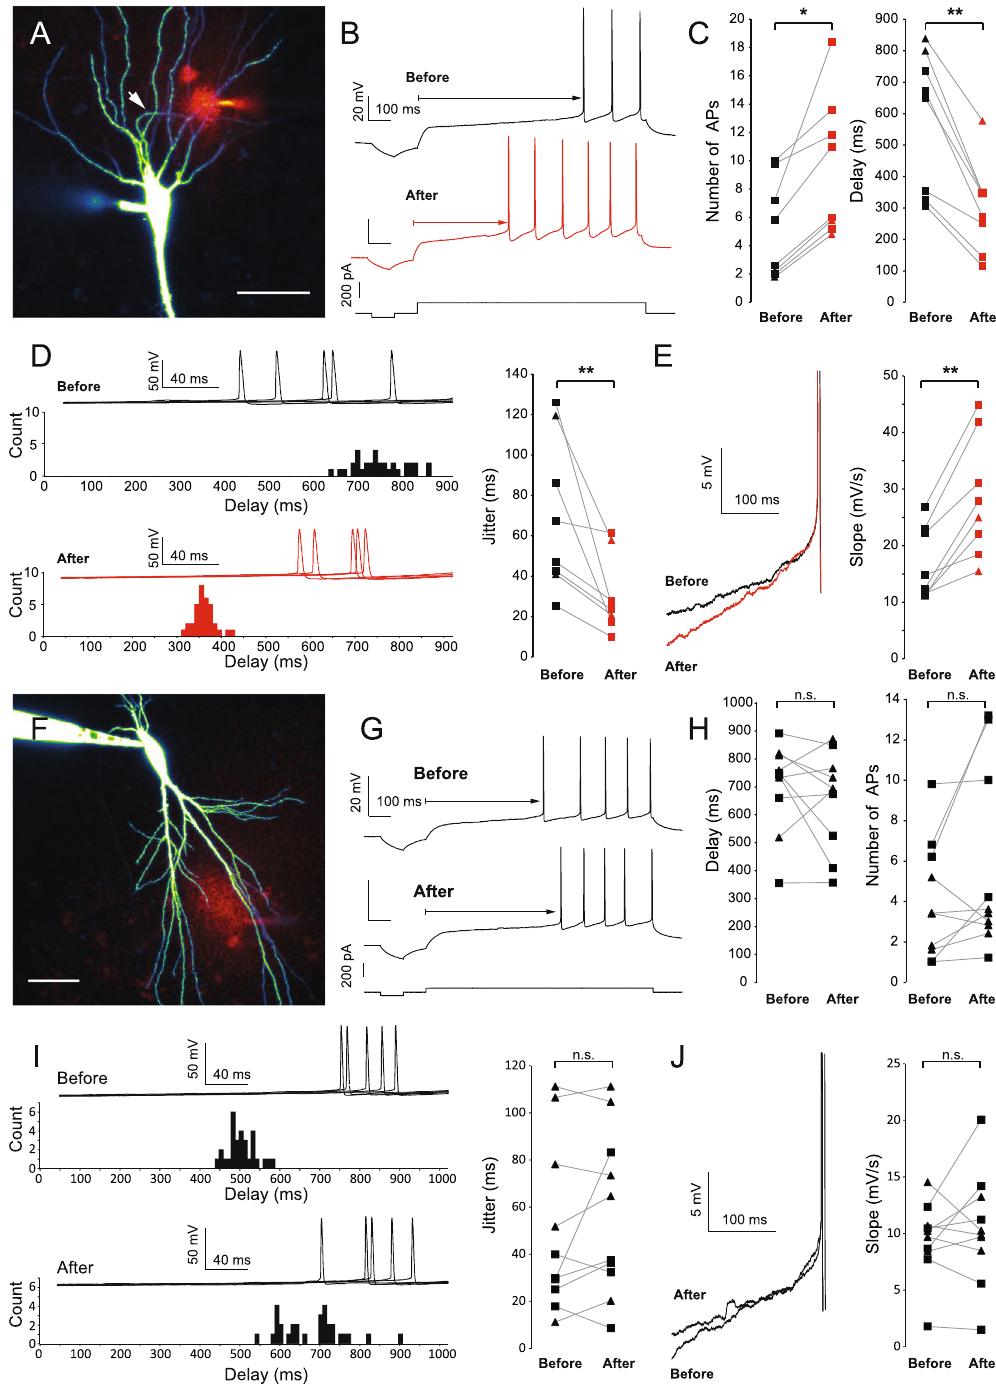
Figure 2. DTx puffs on the axon increase somatic excitability. ( A ) Puff of DTx-K and Alexa 594 on the axon of a CA3 pyramidal neuron filled with Alexa 488. Arrow: axon. Scale Bar: 50 µ m. ( B ) Example of spike discharge before (black) and after (red) 40 puffs of DTx-K on the AIS. Note the increased number of APs and the decreased delay to the first spike. ( C ) Pooled data of the impact of DTx-K and DTx-I puffs on the axon (0– 150 µ m from the soma). Stars: Wilcoxon test, p < 0.05, n = 8. ( D ) Effect of DTx puffs on the jitter of the first AP. Stars: Wilcoxon test, p < 0.05, n = 8. ( E ) Effect of DTx puffs on the depolarizing slope before the first AP (traces aligned on the spike threshold). Stars: Wilcoxon test, p < 0.05, n = 8. ( F ) Puff of DTx-K and Alexa 594 on the dendrites of a CA3 pyramidal neuron filled with Alexa 488. Scale Bar: 50 µ m. ( G ) Example of spike discharge before (top) and after (bottom) 40 puffs of DTx-K on the dendrites. ( H ) Pooled data of the impact of DTx-K and DTx-I puffs on the dendrites (0–150 µ m from the soma). ( I ) Effect of dendritic puff of DTx on the jitter of the first spike. ( J ) Effect of DTx puffs on the depolarizing slope before the first AP. For panels C, D, E, H, I & J: squares: puffs of DTx-K, triangles: puffs of